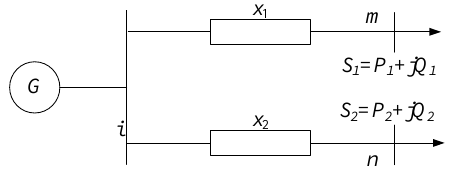
Figure 3. A simple power system for illustration.